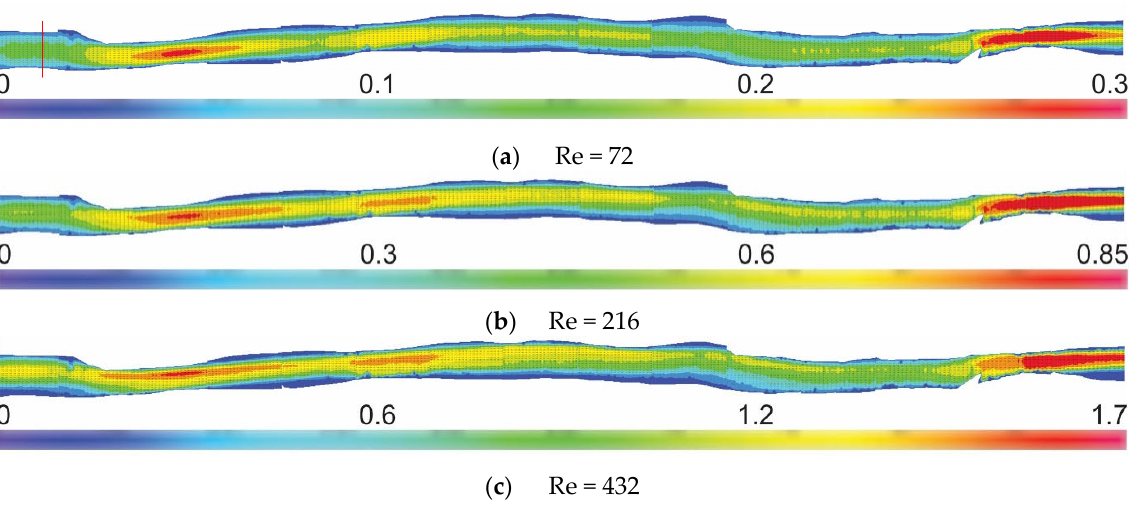
Figure 8. Vector statistics and velocity magnitudes (m/s) along the whole blood vessel for different Re numbers. The red line in ( a ) shows the place where the Reynolds numbers were calculated.